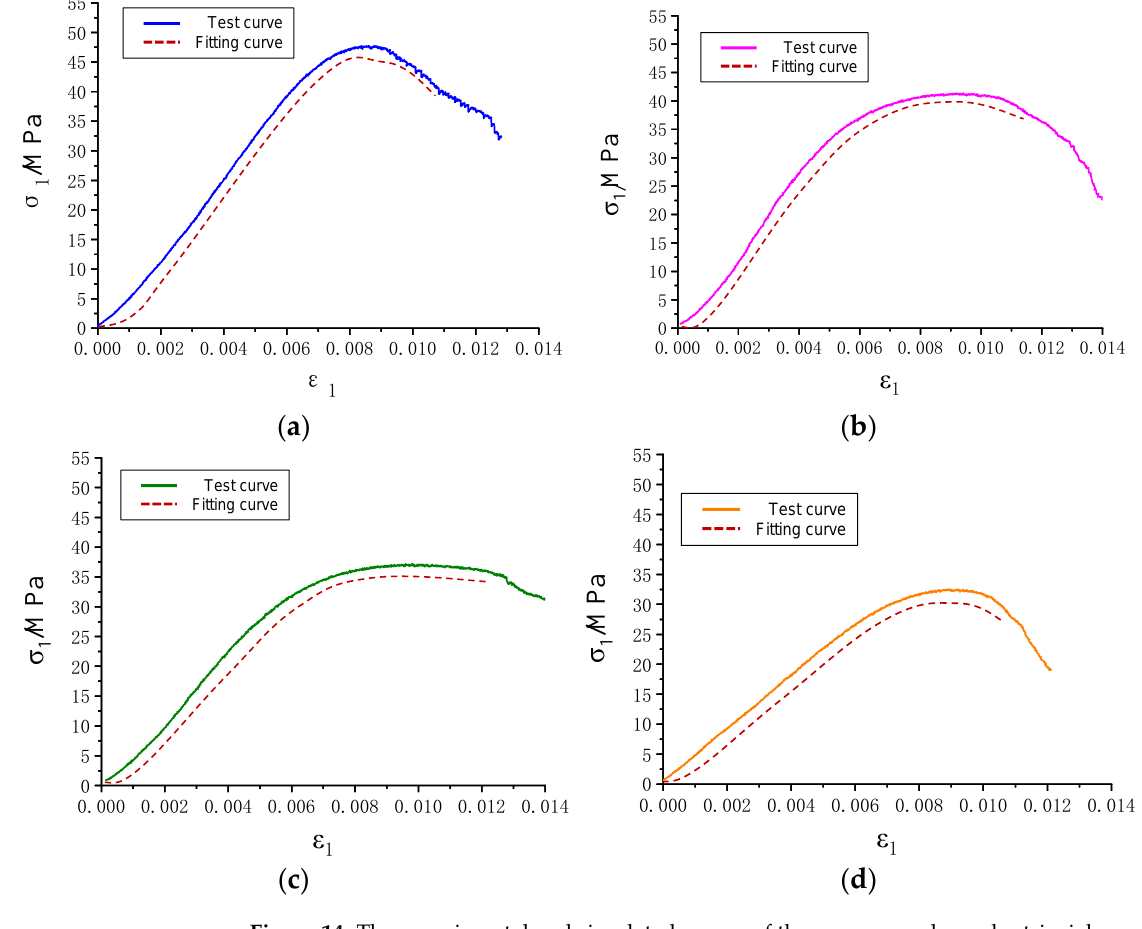
Figure 14. The experimental and simulated curves of the gypsum rocks under triaxial compressions after immersion in water for different durations: ( a ) 1 day, ( b ) 7 days, ( c ) 15 days, and ( d ) 30 days.